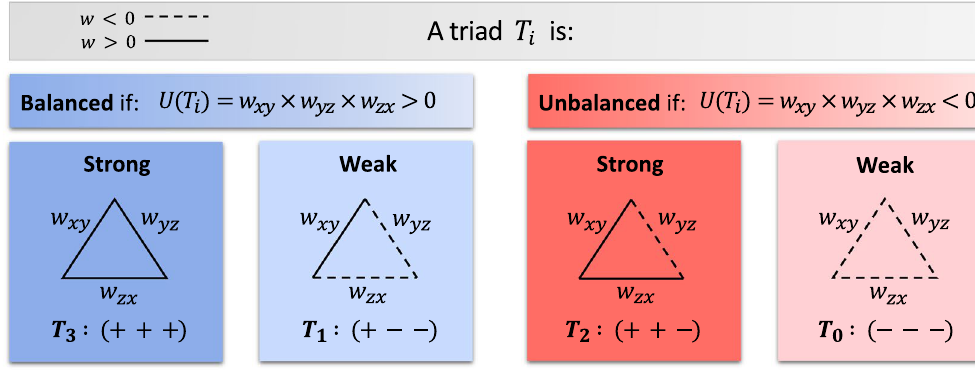
Figure 6. Four types of triads as has been defined in SBT. The number of negative links is even for balanced triads, and odd for unbalanced triads. Furthermore, being strong or weak refers to how much frustration a presence of a triad imposes on a network, with T 2 triads injecting more frustration than T 0 triads, and T 3 being more stable than T 1 triads 14 . w , weights of links; U ( T i ) , energy of T i